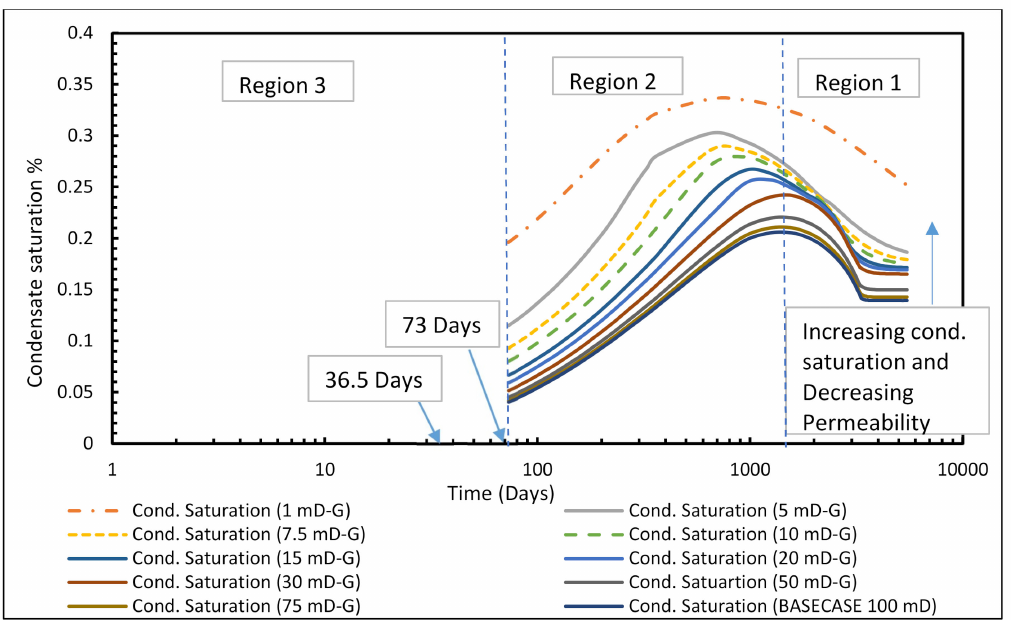
Figure 4. Condensate saturation as a function of time for di ff erent absolute permeabilities at the wellbore: global analysis.